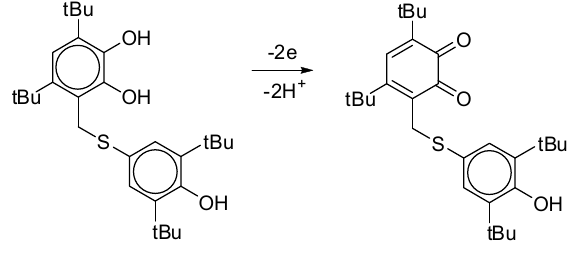
Scheme 3. The first stage of electrochemical oxidation of L 1 .